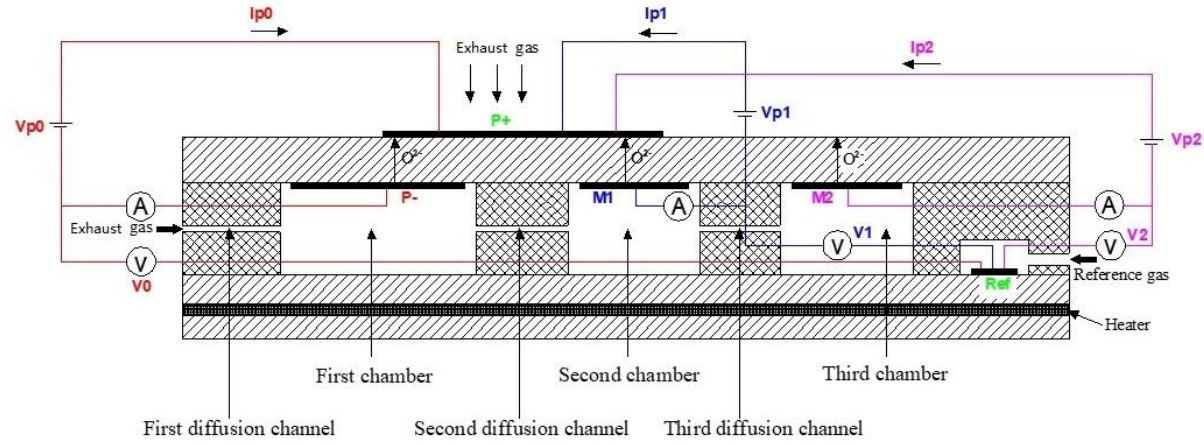
Figure 2. The structure block diagram of NOx sensor ceramic element. Table 1. Symbol description.